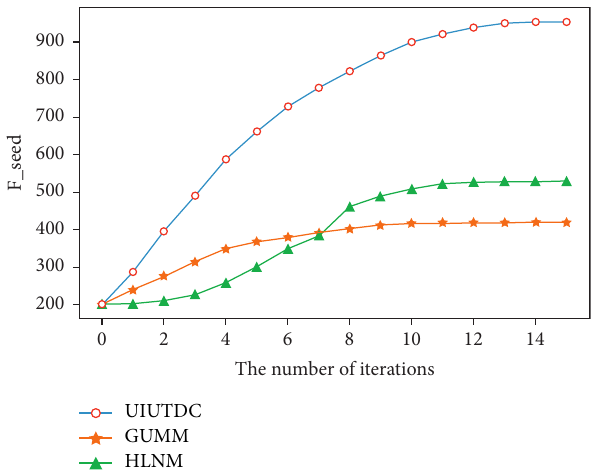
Figure 6: Comparison diagram of 100 prior seed nodes to experiment.